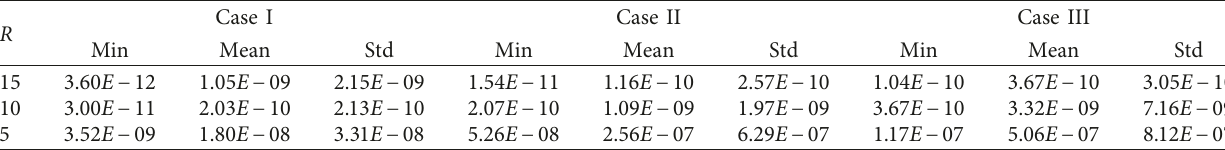
Table 5: Statistics of performance function in terms of mean square error for the influence of variations in R and α in equation (3). R